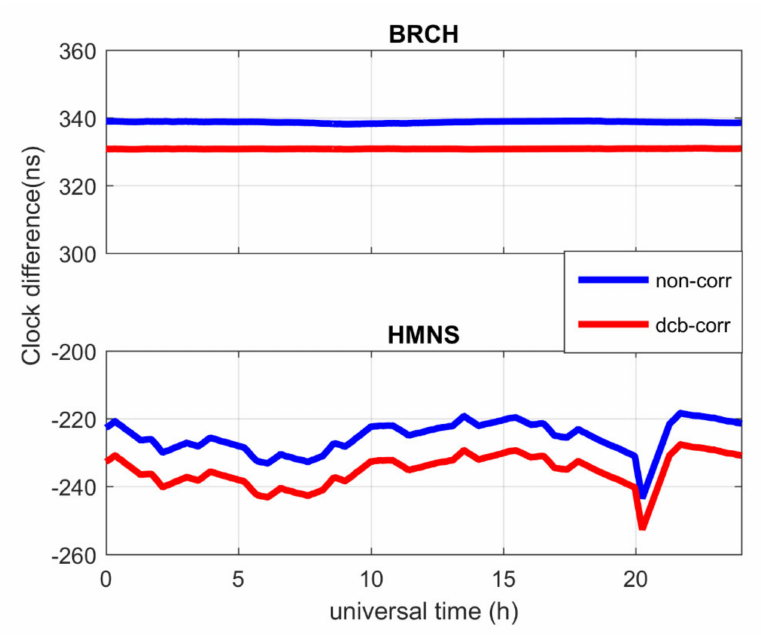
Figure 25. Time series of BDS-3 PPP receiver clock obtained with different schemes at BRCH and HMNS